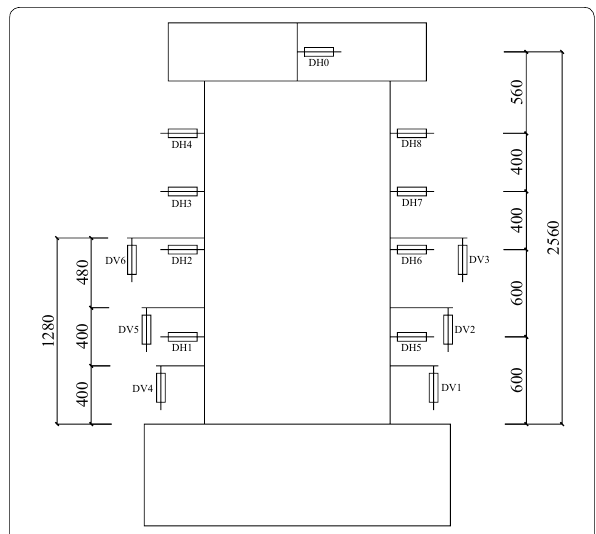
Fig. 6 Arrangements of displacement